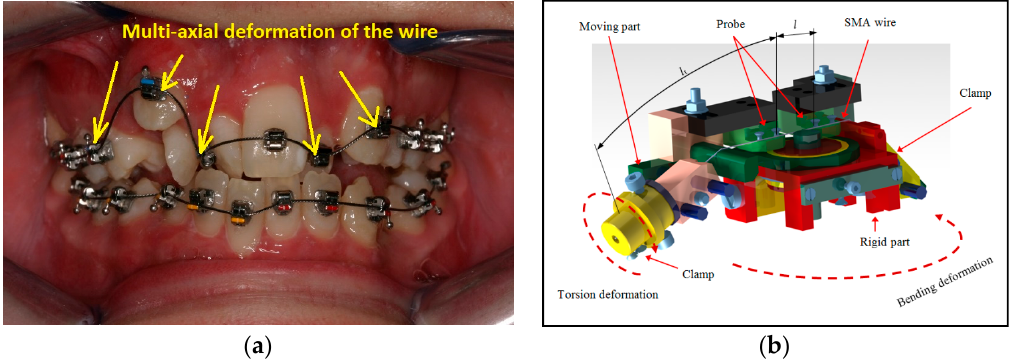
Figure 1. ( a ) Fixed orthodontic appliance (arrow pointing to the bending and torsional stresses of the archwire); ( b ) Simulation of multiaxial stress equipment (SMAS) [23]. Reprinted with permission